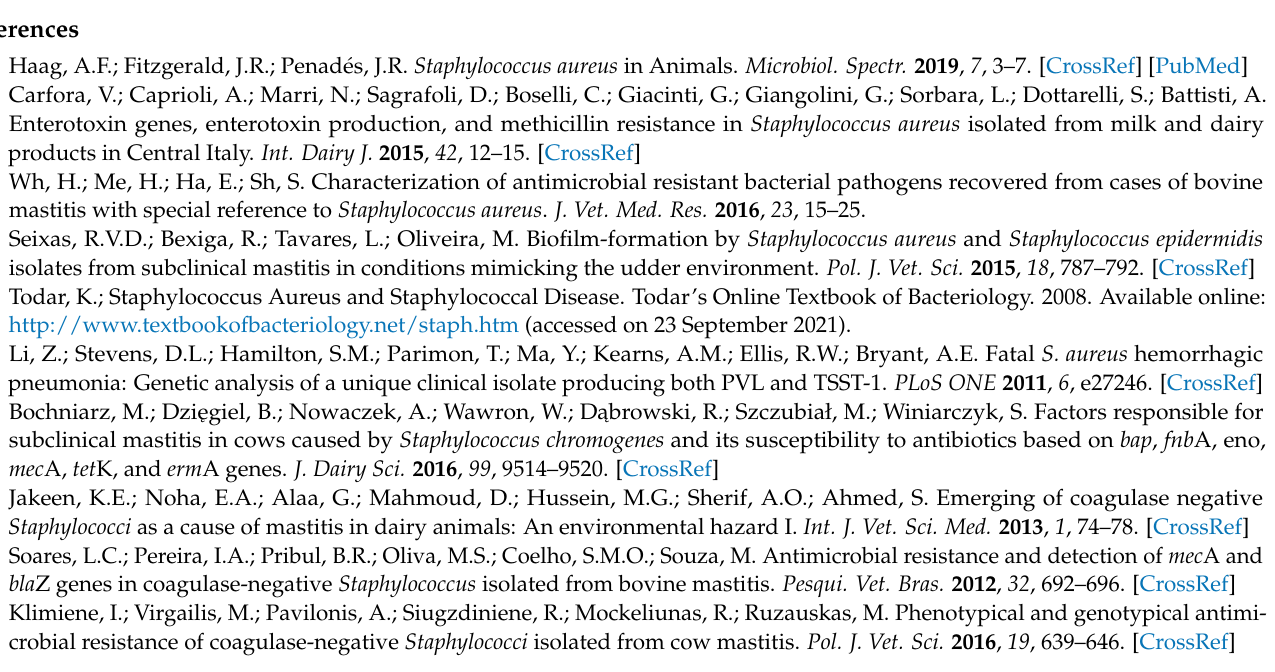
Table S6: Primers sequences, target genes, amplicon sizes and cycling conditions for PCR and RT-PCR assays; Table S7: Cycling conditions of the different primers during